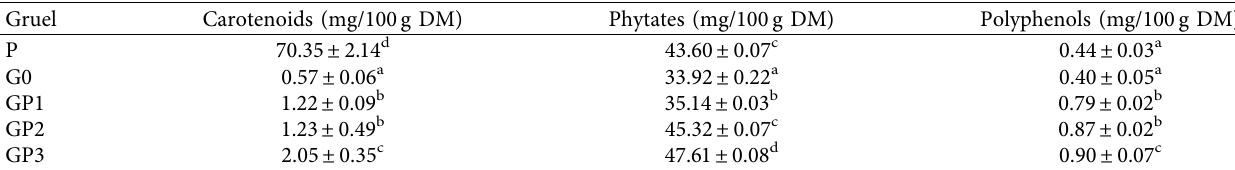
G0: control (unfortifed gruel); GP1: gruel fortifed with mashed sweet potato at 20%; GP2: gruel fortifed with mashed sweet potato at 30%; GP3: gruel fortifed with mashed sweet potato at 40%. Mean values in the same column with diferent superscript letters are signifcantly diferent ( P < 0.05). Table 3: Phytochemical composition of mashed sweet potato and fortifed